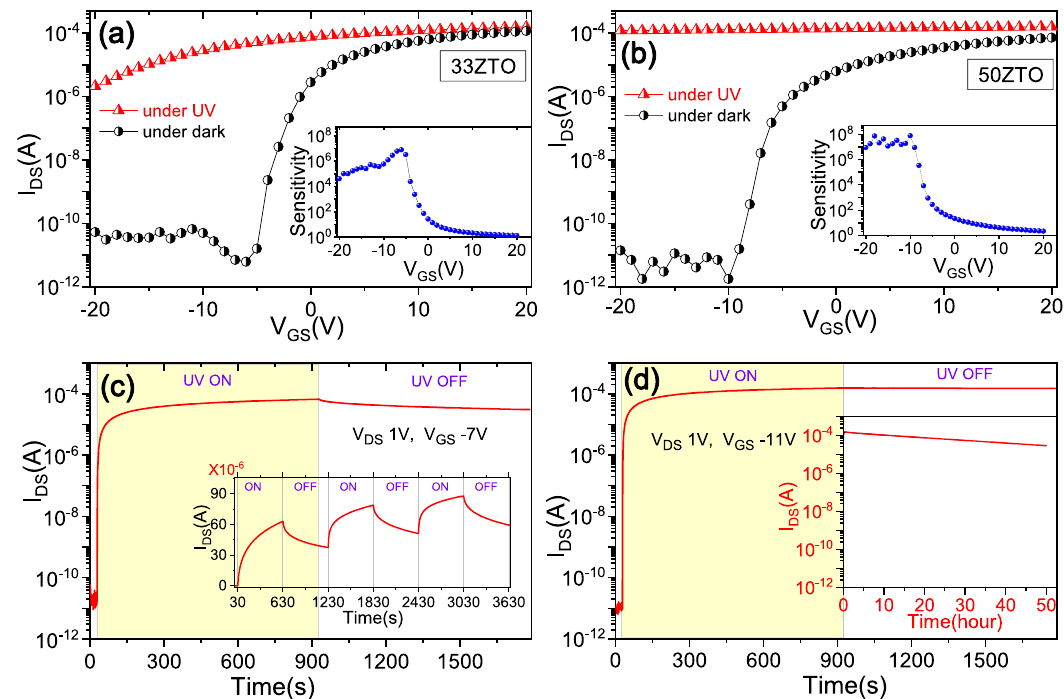
Figure 3. The transfer characteristics of ( a ) 33ZTO and ( b ) 50ZTO TFTs at V DS = 1 V measured in dark and under UV light (at 365 nm) exposure. The sample was exposed to UV light for 5 min at an intensity of 40 mW/ cm 2 before starting the photocurrent–voltage measurement. Insets show the sensitivity (photo-to-dark current ratio) as a function of V GS . In ( c ) and ( d ), the transient response of the drain-to-source current for ZTO photo-TFTs under a single UV light pulse of 15 min for the sample 33ZTO and 50ZTO, respectively. The inset in ( c ) shows photoresponse of 33ZTO under a periodic UV pulse (10 min). The inset in ( d ) shows extended measurement (up to 50 h) of drain-to-source photocurrent after switching off the UV